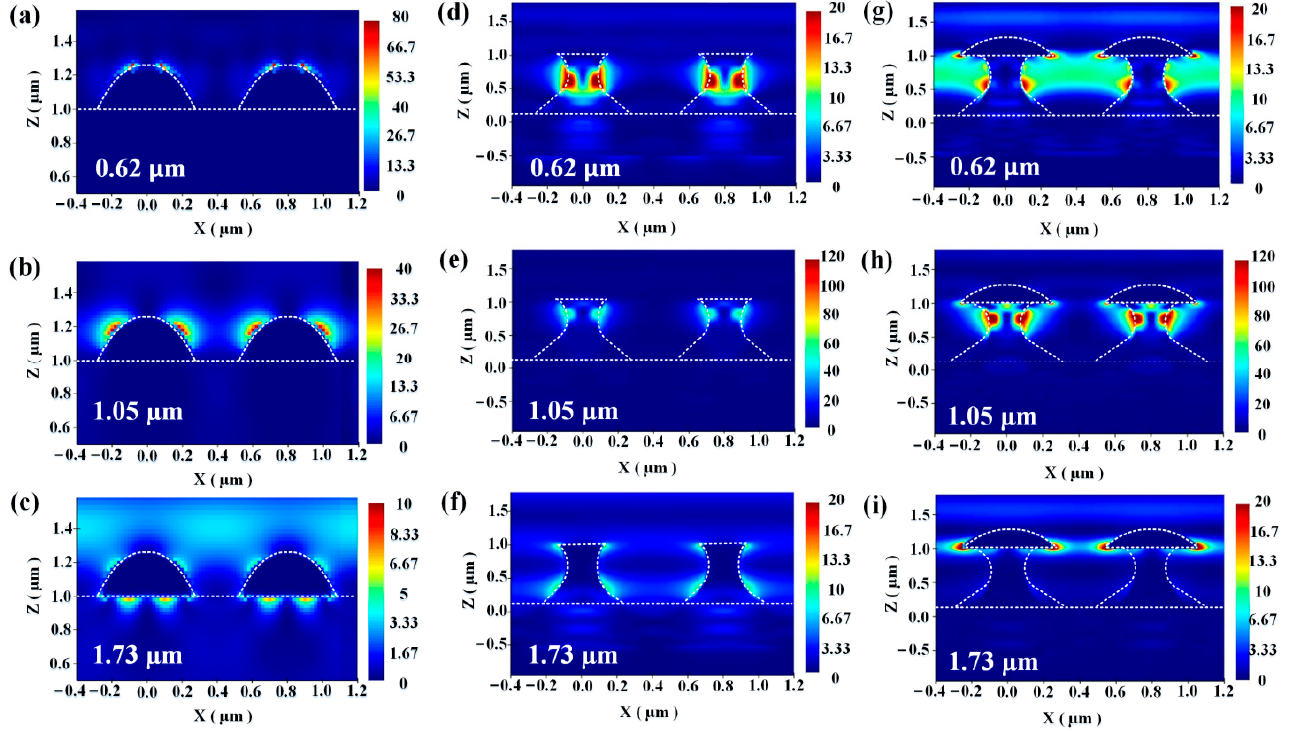
Figure 10. The measured electric field distribution on adjacent Ag NPs on Si substrate ( a – c ) and nanostructures without Ag NPs ( d – f ) and with Ag NPs ( g – i ) at different incident wavelengths: 0.62 µ m, 1.05 µ m, and 1.73 µ m (Scales are | E | 2 ). individual Ag NPs at different wavelengths, which contribute to the enhanced